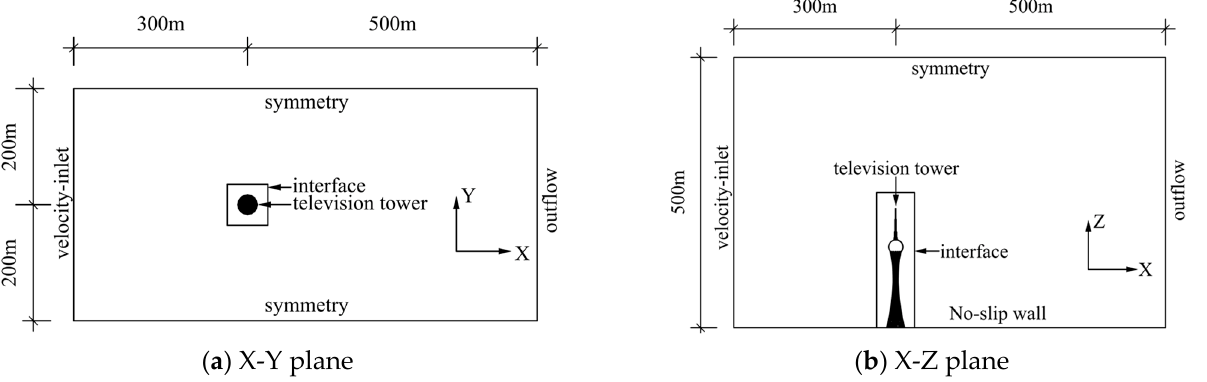
Figure 18. Boundary conditions of the computational domain and definition of the coordinate system.